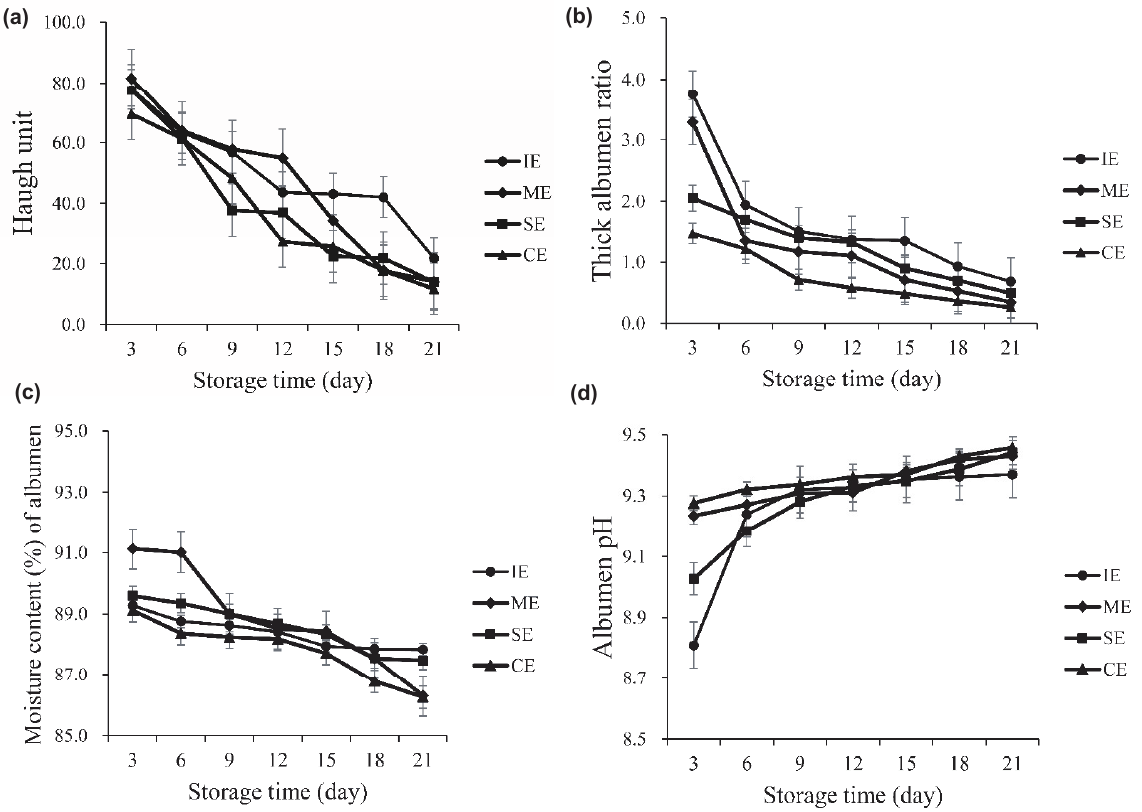
Figure 2. Changes in (a) Haugh unit, (b) thick albumen ratio, (c) moisture content (%) of albumen, and (d) albumen pH of different categories of eggs during storage. IE, intact egg; ME, minor stripe-marked egg; SE, severe stripe-marked egg; CE, cracked